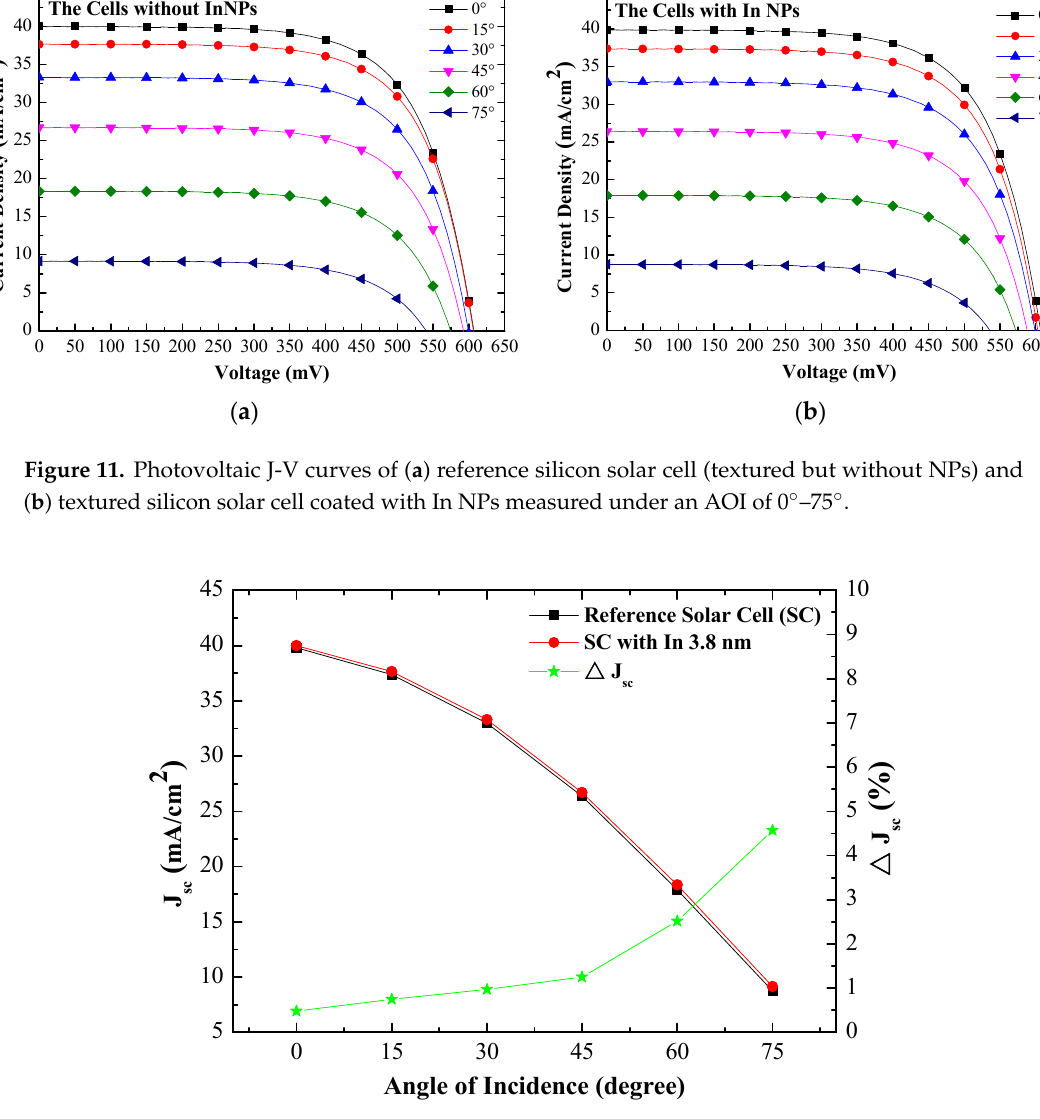
Figure 12. Improvements in J SC and J SC as a function of incident angle in textured silicon solar cells with and without a layer of In NPs. Table 3. Photovoltaic performance of textured silicon solar cells evaluated in this work, as measured under AOI of 0°–75°. Reference Solar Cell The Cell with In